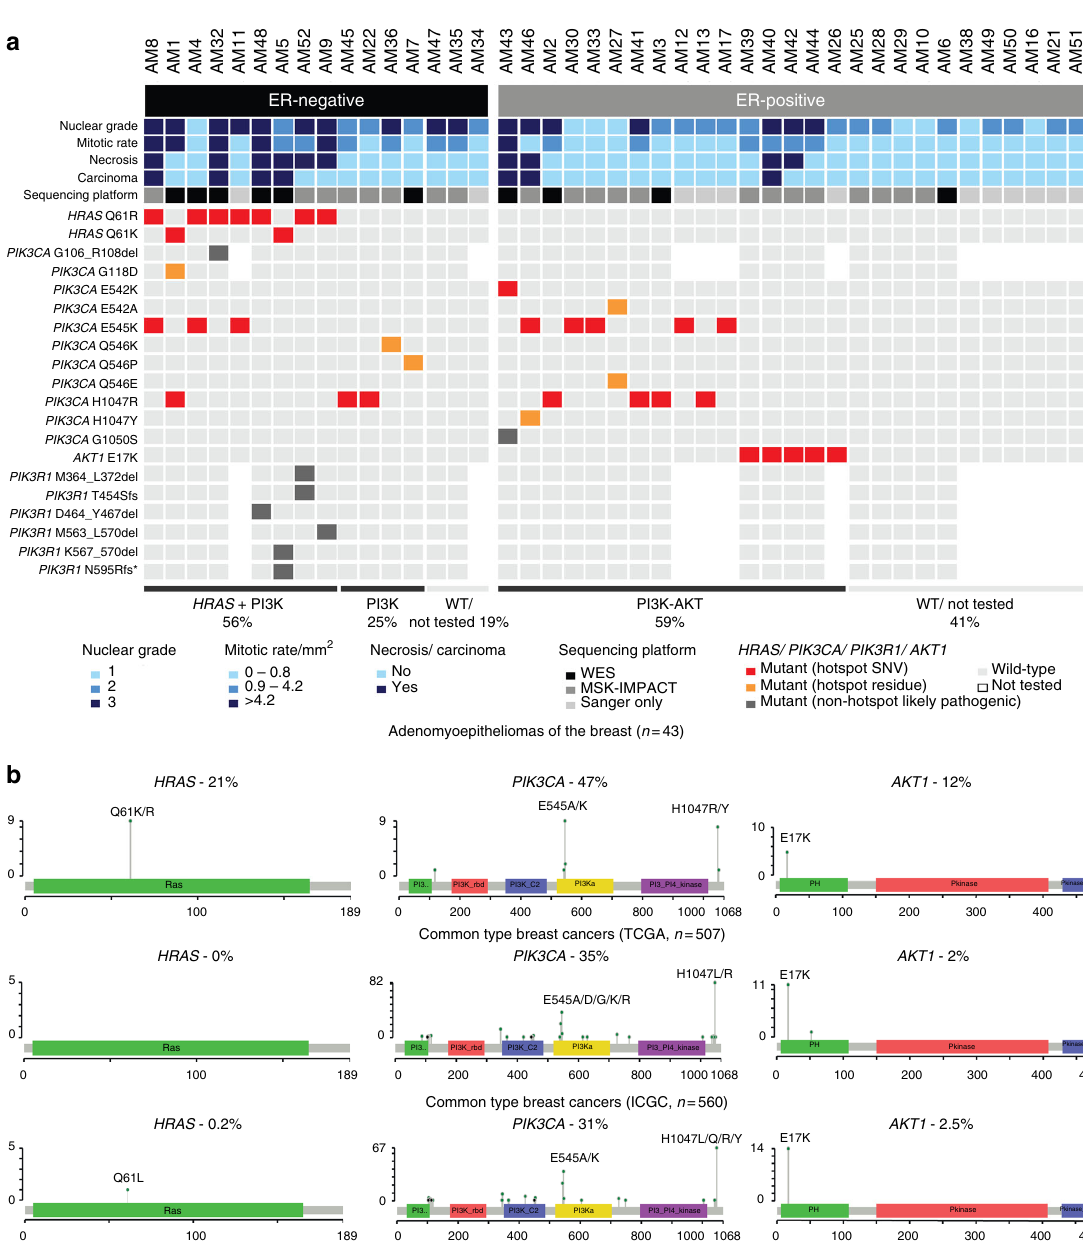
Fig. 3 Somatic mutations affecting HRAS and PI3K-AKT pathway-related genes in breast adenomyoepitheliomas. a Heatmap depicting somatic mutations affecting HRAS, PIK3CA , AKT1, and PIK3R1 identi fi ed in 43 breast adenomyoepitheliomas by (i) both massively parallel sequencing (WES or MSK-IMPACT) and Sanger sequencing or (ii) Sanger sequencing only. Cases are shown in columns (estrogen receptor (ER)-negative cases on the left; ER-positive cases on the right), and genes in rows. Histopathologic characteristics and sequencing platforms are shown at the top, and color-coded according to the legend at the bottom. Hotspot mutations were obtained from Chang et al. 57 . SNV, single nucleotide variant; WES, whole-exome sequencing; WT, wild-type. b Spectrum of somatic mutations affecting HRAS, PIK3CA , and AKT1 identi fi ed in the 43 breast adenomyoepitheliomas analyzed in this study, and in unselected breast cancers from The Cancer Genome Atlas (TCGA, n = 507) 6 and International Cancer Genome Consortium (ICGC, n = 560) 7 studies. Diagrams representing the protein domains of HRAS encoded by HRAS (left), p110 α encoded by PIK3CA (middle), and AKT1 encoded by AKT1 (right). The mutations in these three genes are shown on the x -axis, and the height of each “ lollipop ” indicates the frequency of the mutation ( y -axis). Missense mutations are depicted as green circles, and small insertions and deletions are shown in black circles. Plots were generated using MutationMapper on cBioPortal (www.cBioPortal.org) and were manually edited HRAS , and AKT1 , respectively, in the 12 additional cases (Fig. 3a, In ER-positive adenomyoepitheliomas, mutations affecting Supplementary Fig. 2b, Supplementary Data 3). Mutations PIK3CA or AKT1 were found in 59% (16/27) of cases, whereas affecting PIK3CA, AKT1 , and PIK3R1 were found to be in ER-negative adenomyoepitheliomas, mutations affecting signi fi cantly mutually exclusive ( n = 43, P = 0.0004, CoMEt exact PIK3CA or PIK3R1 were detected in 81% of the cases tested test), whereas all HRAS mutations signi fi cantly co-occurred with (Fig. 3a). Within ER-positive adenomyoepitheliomas, the pre- PIK3CA or PIK3R1 mutations ( n = 43, P value for co-occurrence sence of PIK3CA or AKT1 mutations was signi fi cantly associated = 0.025, Z test). with marked nuclear pleomorphism and moderate-to-high | DOI: 10.1038/s41467-018-04128-5 |